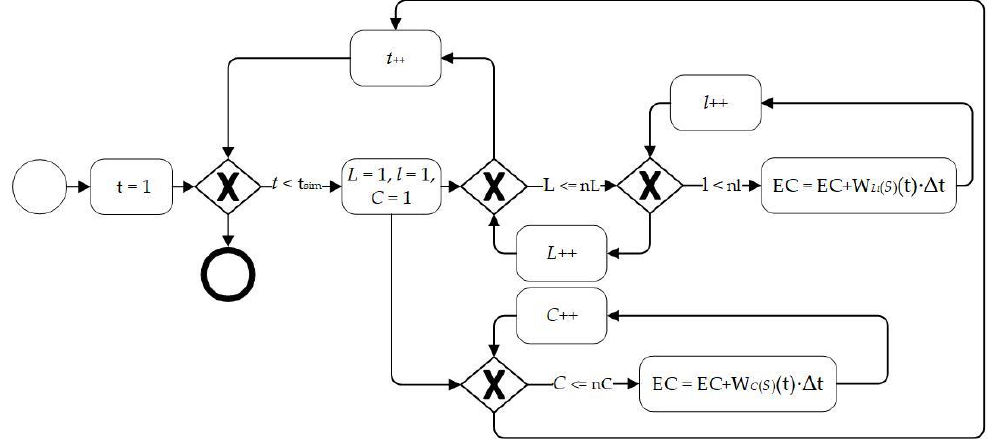
Figure 5. Algorithm for calculating energy